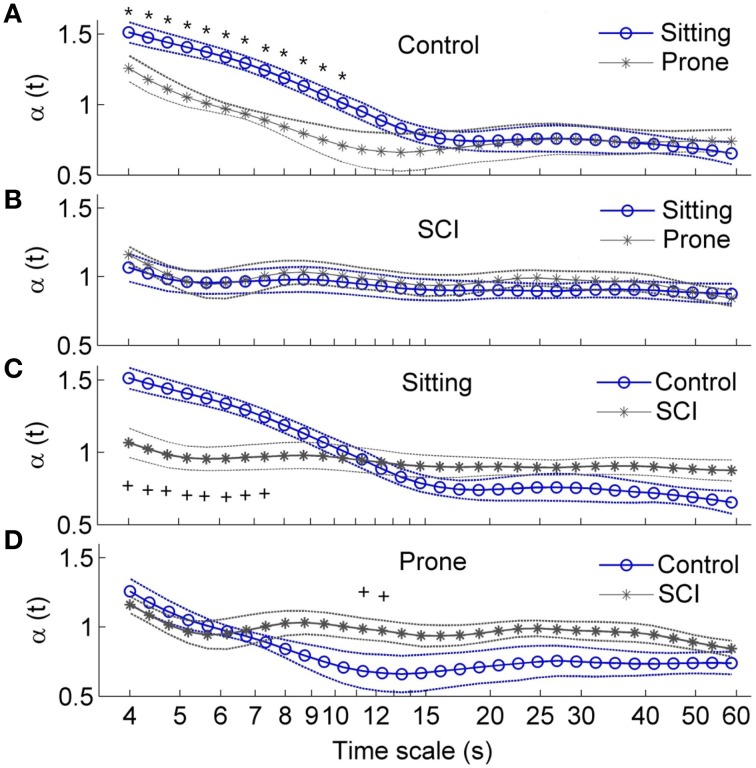
Local scale exponents αt in healthy able-bodied controls and subjects with SCI. Values are presented as means ± SE. *p < 0.05 for within-subjects test; +p < 0.05 for between-subjects test. (A) Comparisons of α(t) in control group between two postures. (B) Comparisons of α(t) in SCI group between two postures. (C) Comparison of α(t) in the sitting position between two groups. (D) Comparisons of α(t) in the prone position between two groups.